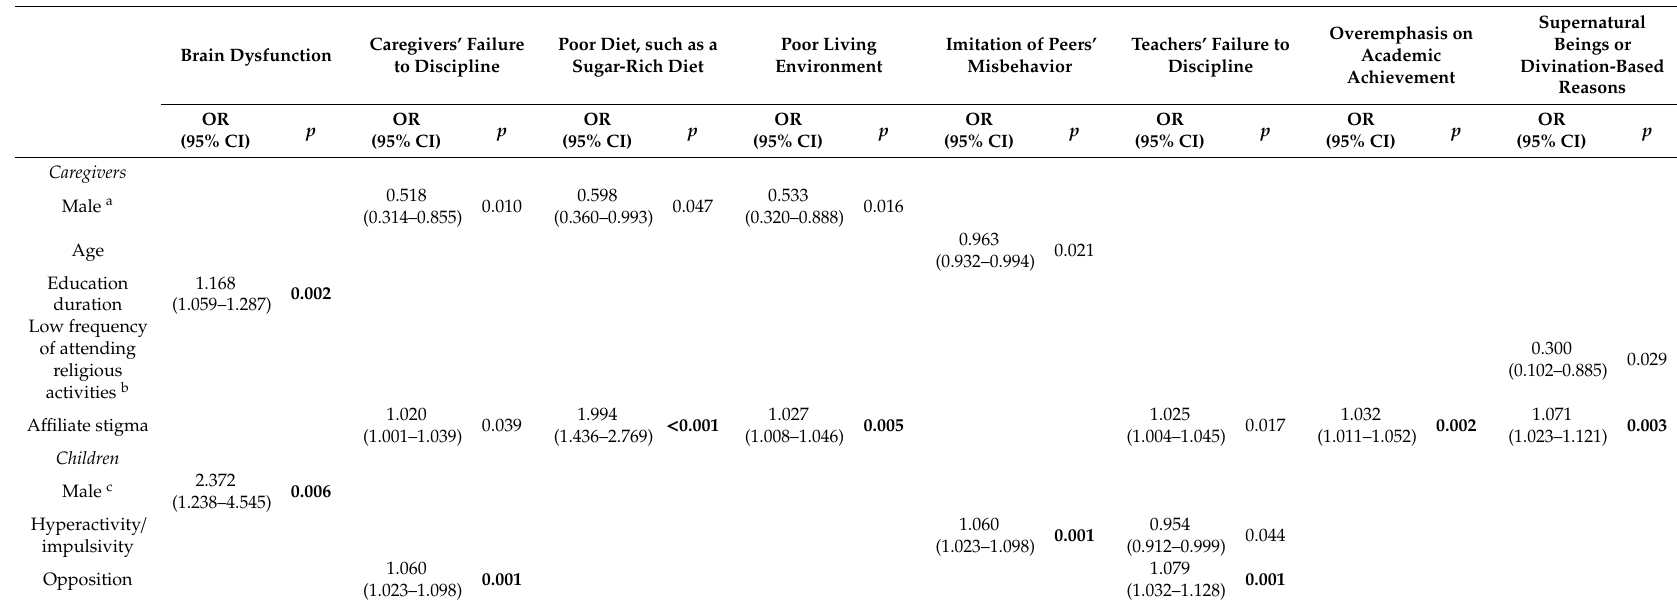
Table 3. Factors related to the etiologies of ADHD attributed by